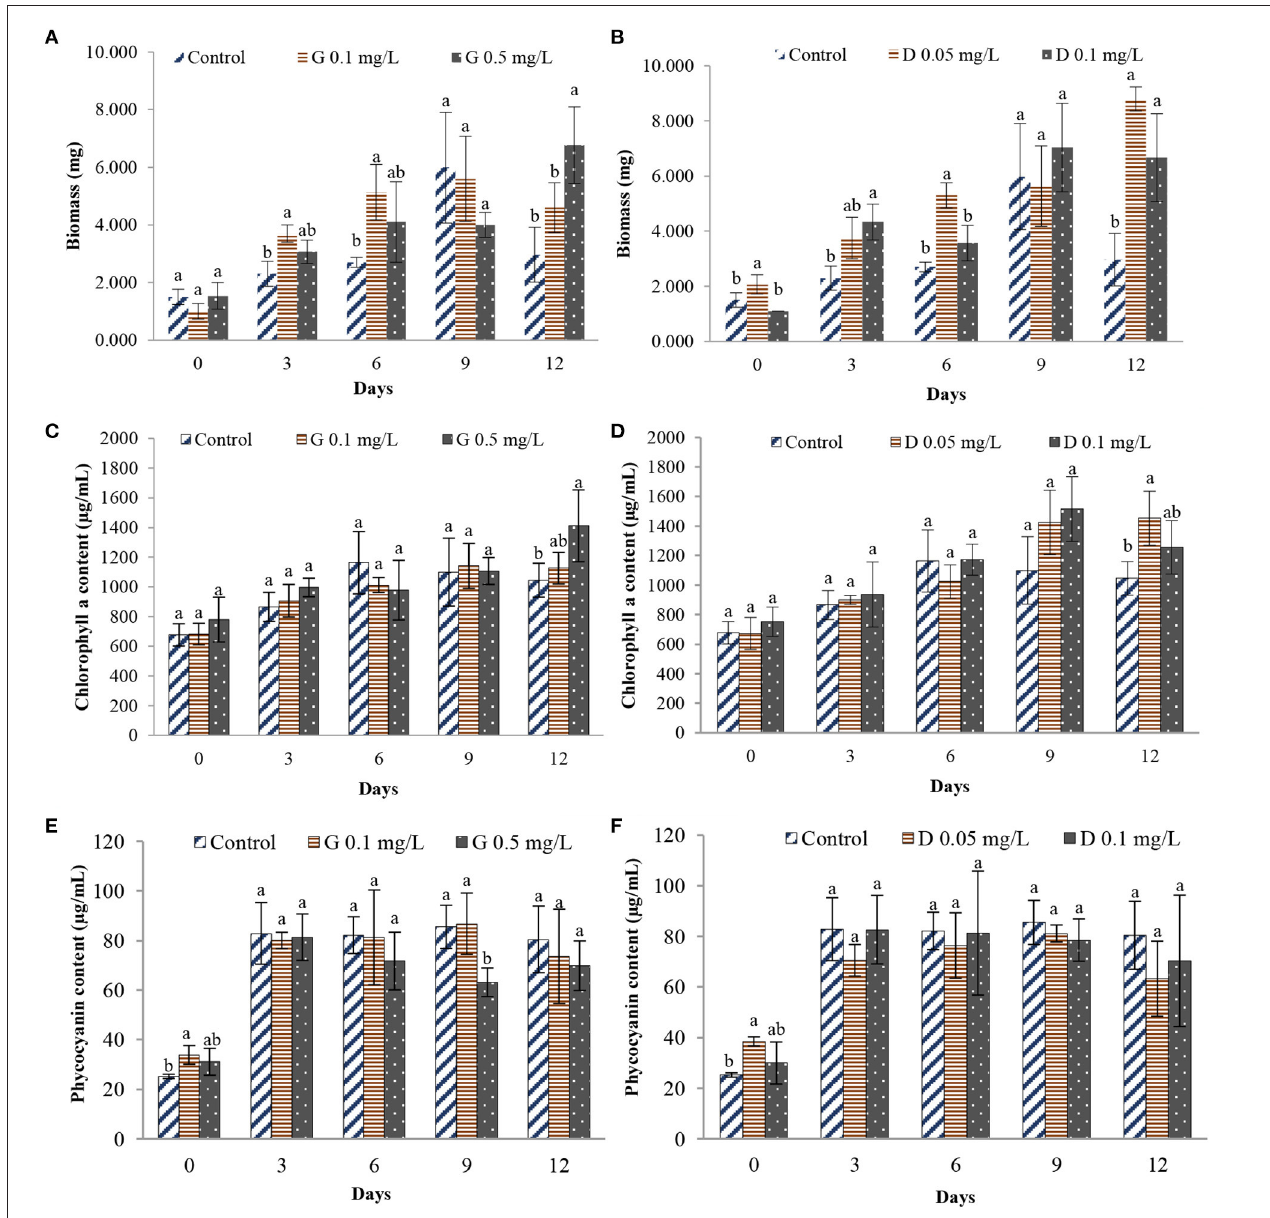
FIGURE 1 | Effects of glyphosate and 2,4-D herbicides on the biomass and pigment contents of Nostoc sp. N1. (A) Effect of glyphosate herbicide on the biomass (B) Effect of 2,4-D herbicide on the biomass (C) Effect of glyphosate herbicide on the chlorophyll a content (D) Effect of 2,4-D herbicide on the chlorophyll a content (E) Effect of glyphosate herbicide on the phycocyanin content (F) Effect of 2,4-D herbicide on the phycocyanin content. G, Glyphosate herbicide; D, 2,4-D herbicide. The same letter are not significantly different at P = 0.05.